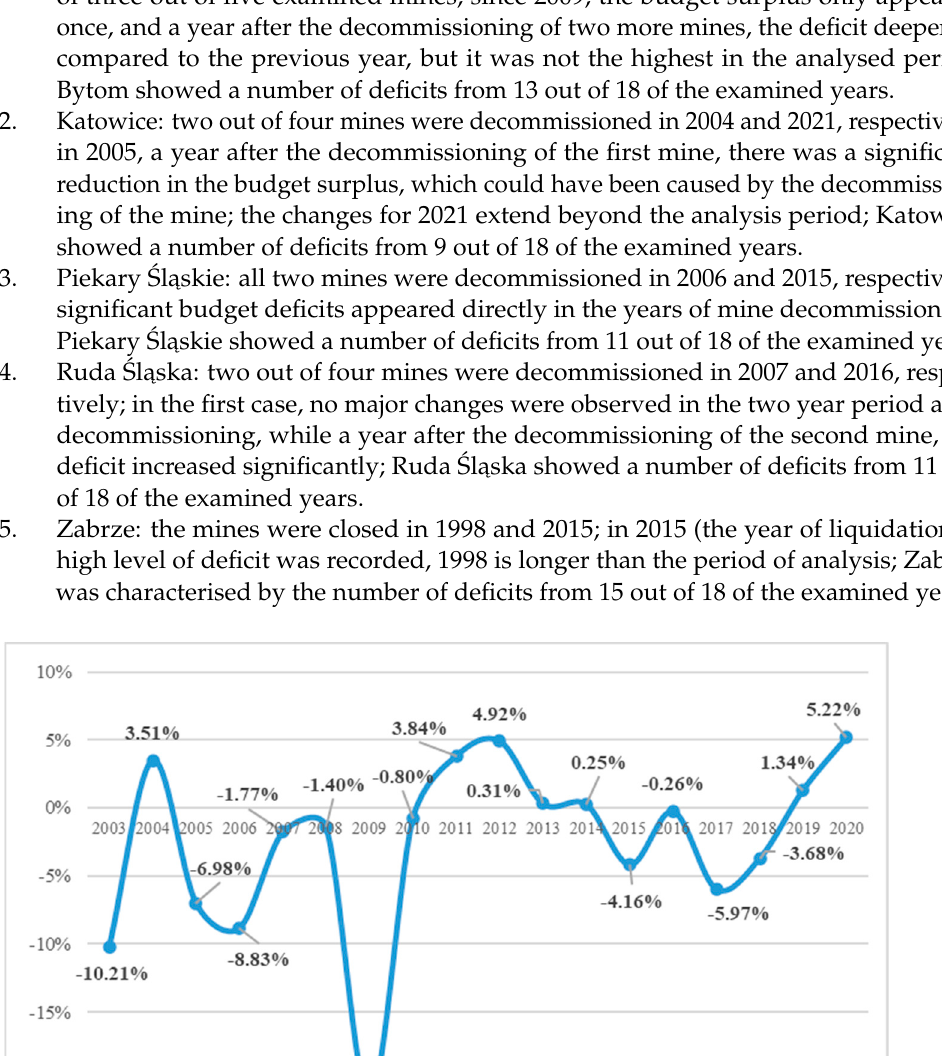
Figure 5. Ratio of the budget deficit/surplus to the annual budget revenues for 2003-2020 (in %) for the city of Zabrze. Source: own elaboration. Table 2. Statistics for deficits/surpluses of the examined cities. City